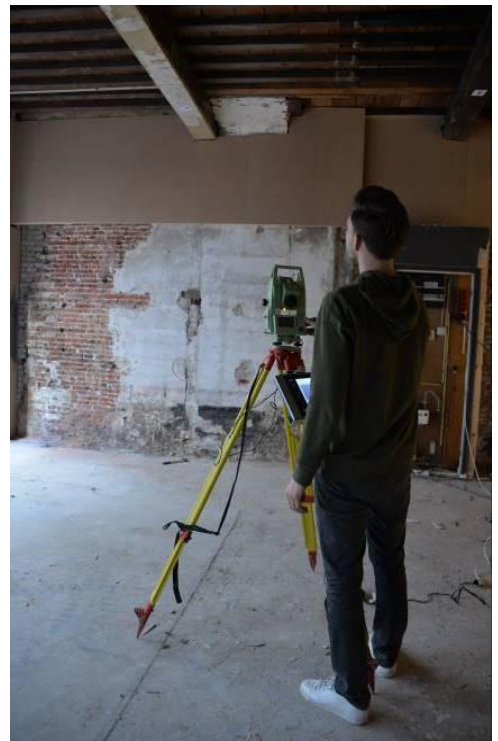
Figure 4. Recording targets with a Total Station connected to a tablet with BricsCAD to support the photogrammetric survey